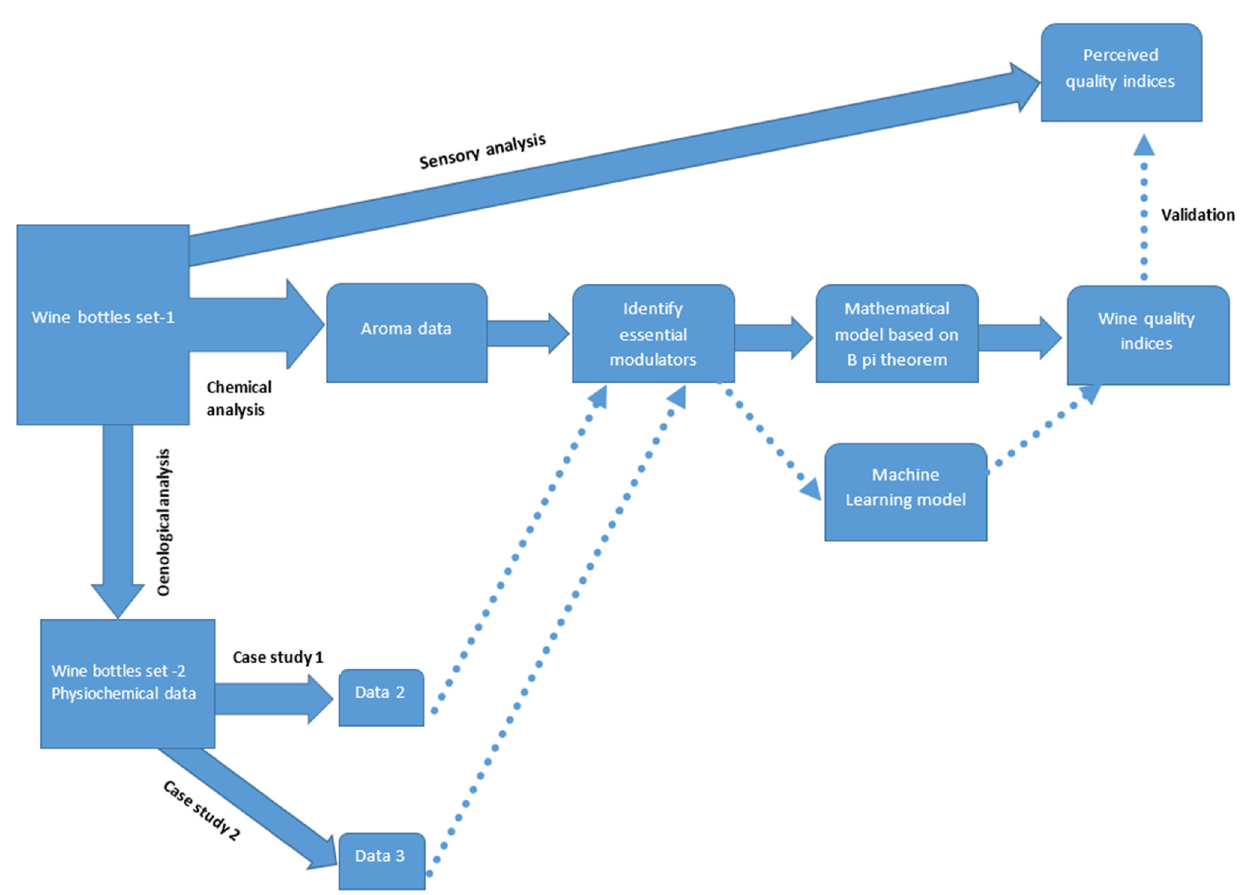
Figure 2. Schematic of developed mathematical framework and validation through two case studies and machine learning model. To produce perceived wine quality indices, a thorough sensory analysis was performed for two 18-wine sets of New Zealand Pinot noir wine (Experiment 1 and Experiment 2) in the first phase, and another set of 18 New Zealand Pinot noir wines (Experiment 3) for the second phase of this research. Based on an extensive literature review and threshold values of different chemical compounds found in the Pinot noir wine bottle, essential modulators are chosen from the available chemical data for set 1 (chemical analysis). These crucial modulators are modelled using the Buckingham Pi theorem in the later stages, and the wine quality indices for bottles of Pinot noir are eventually predicted. These quality indicators are compared to the wine quality indices that were obtained initially through sensory analysis. The model validation phase is completed using machine learning methods.